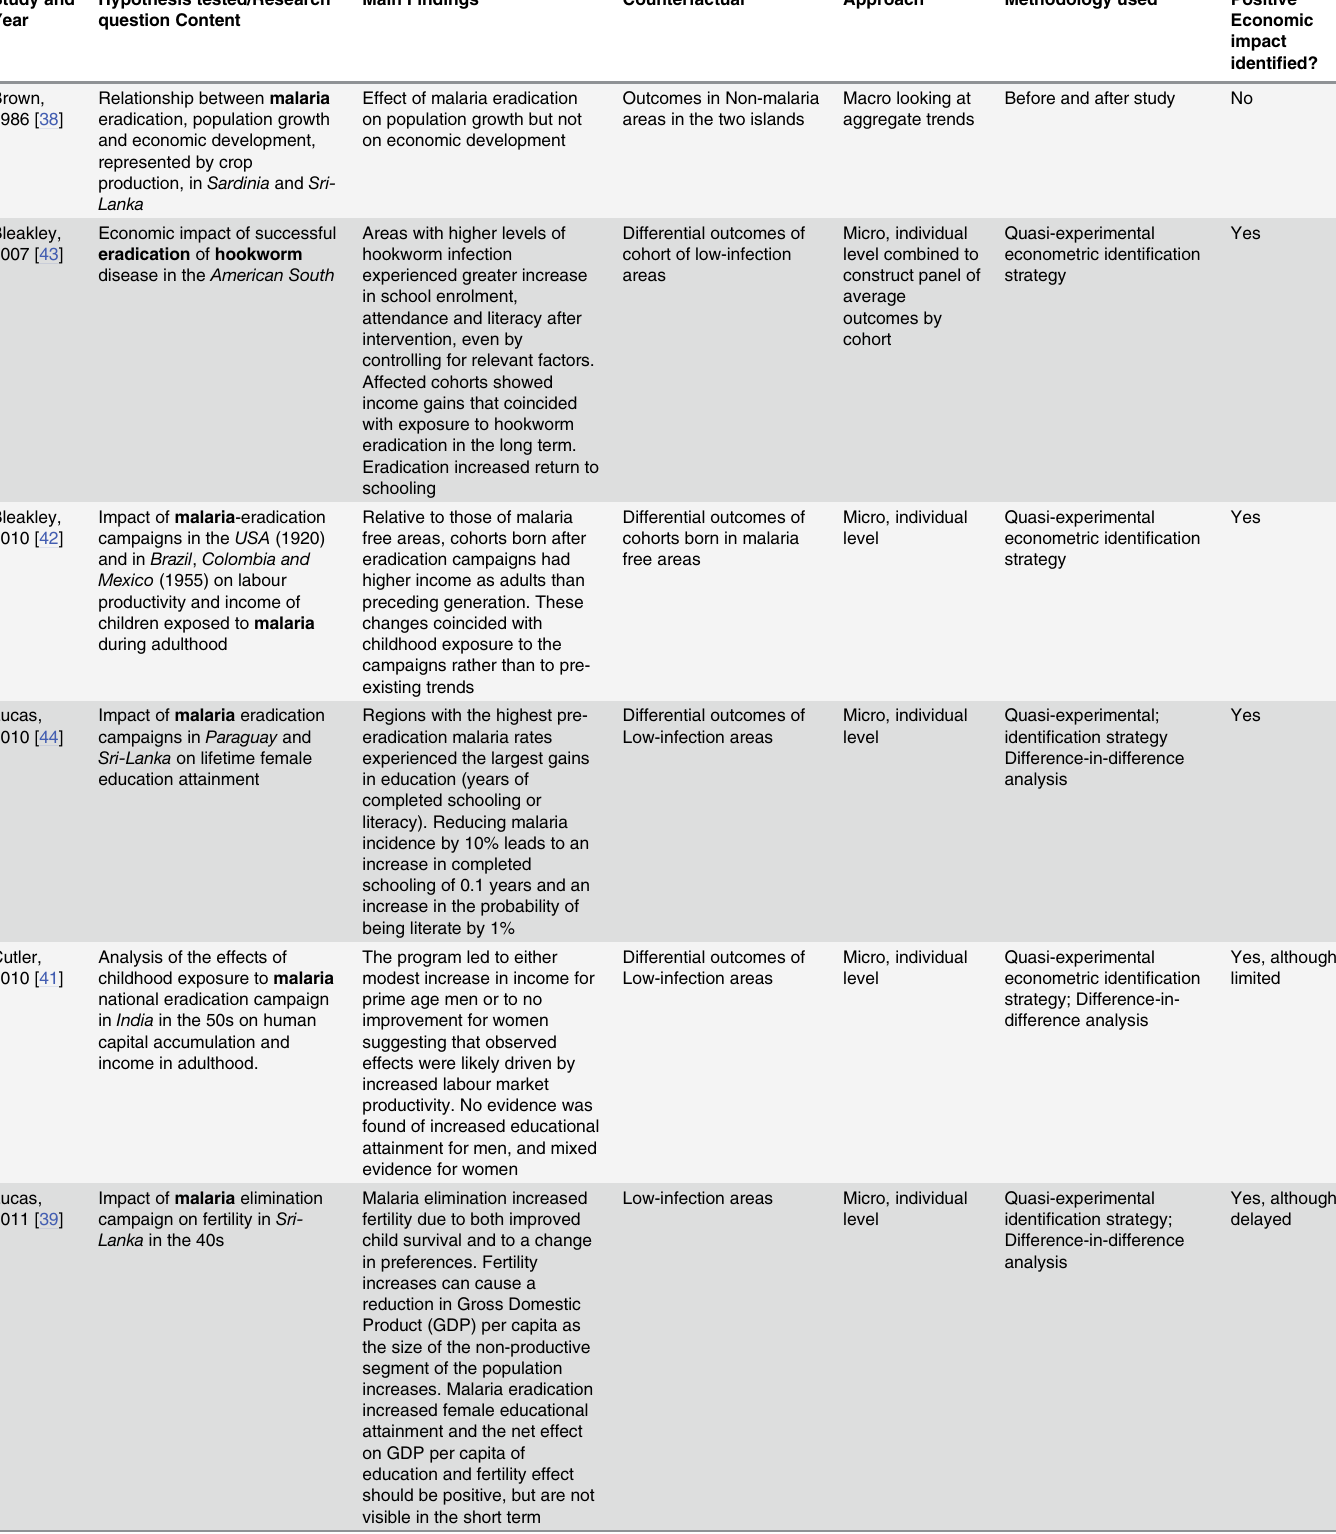
Table 2. Why to eliminate/eradicate: The impact of elimination/eradication on economic development, human capital accumulation. Study and